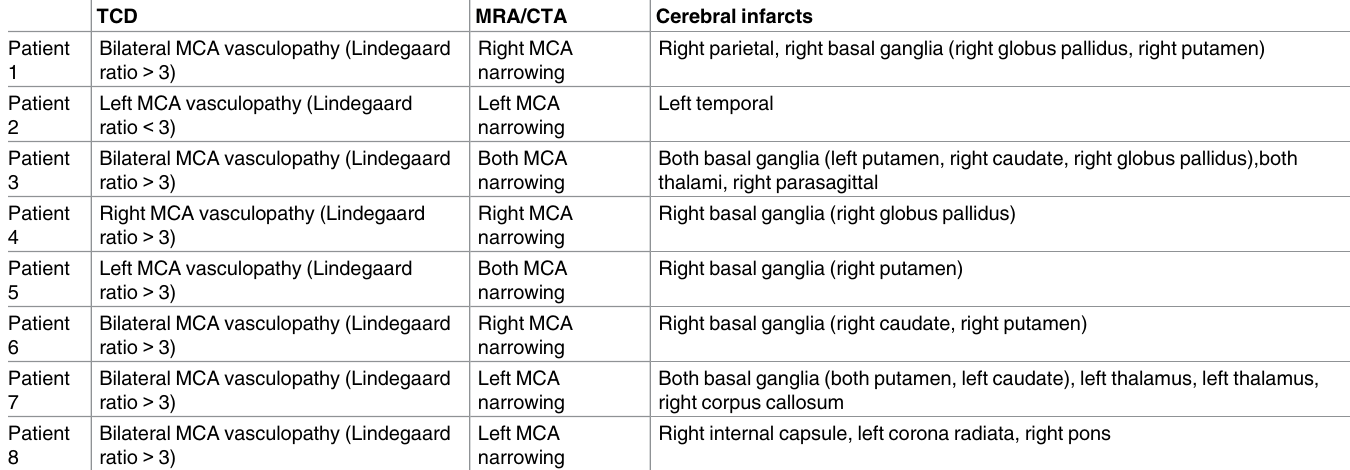
Table 3. Patients who fulfilled the diagnostic criteria of MCA stenosis in both serial TCD and MRA/CTA studies and their cerebral infarcts.